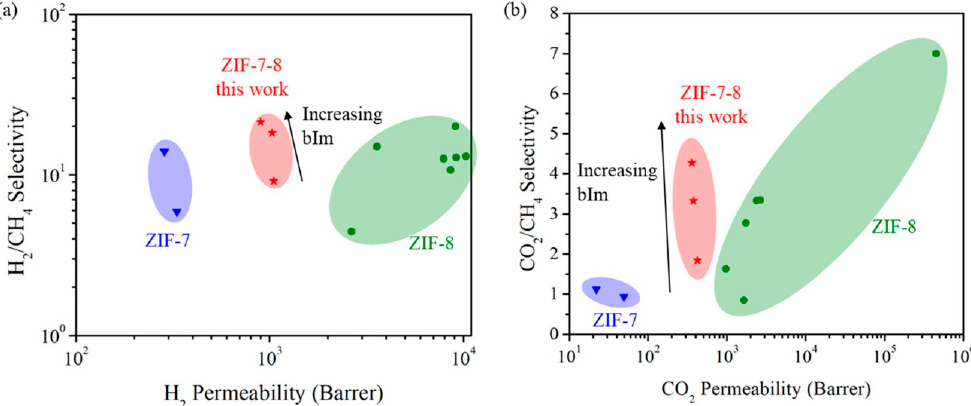
Figure 57. Comparison of ( a ) H 2 /CH 4 and ( b ) CO 2 /CH 4 separation performance for mixed-ligand ZIF-7-8 membranes with the parent ZIF membranes (ZIF-7 and ZIF-8). 1 Barrer = 3.348 × 10 –16 mol m m –2 s –1 Pa –1 (adapted with permission from ref. [66]).